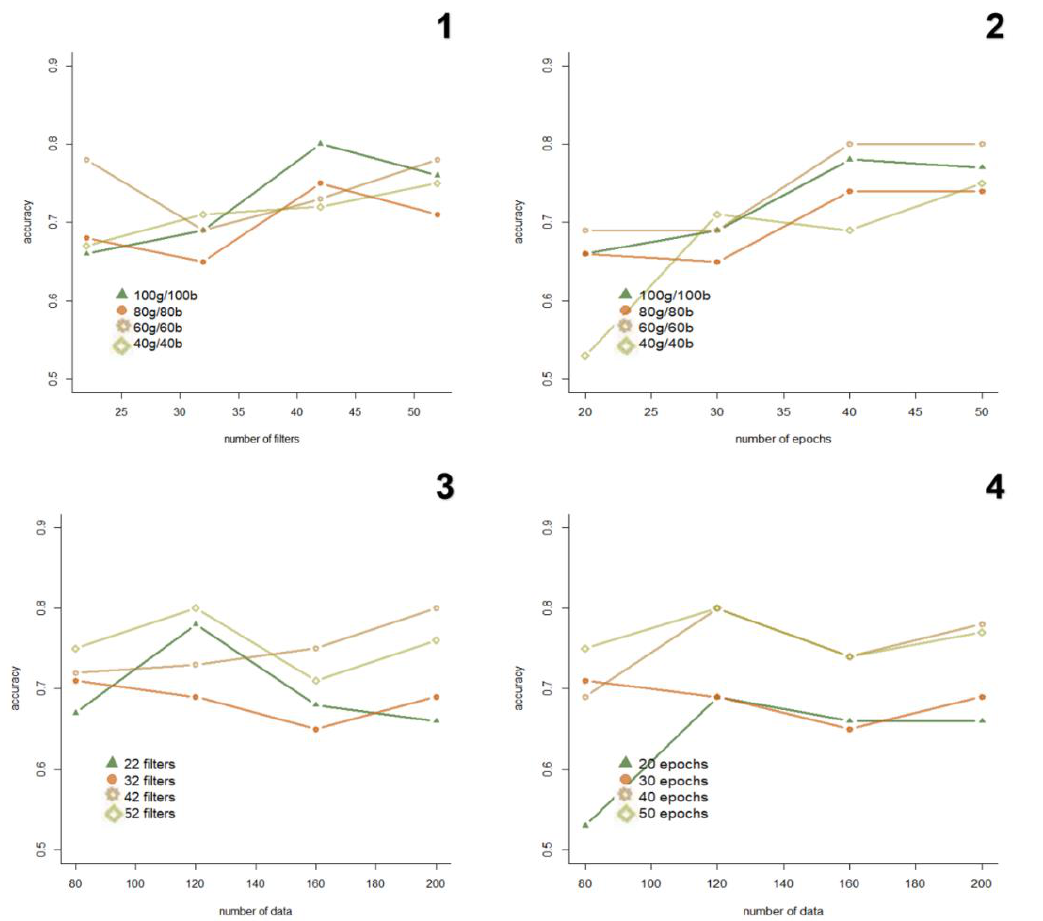
Figure 4. Changes of accuracy based on di ff erent numbers of parameters: Plot 1 , Changes of accuracy based on di ff erent numbers of filters with constant 30 epochs; Plot 2 , Changes of accuracy based on di ff erent numbers of epochs with constant 32 filters; Plot 3 , Changes of accuracy based on di ff erent numbers of data with constant 30 epochs; Plot 4 , Changes of accuracy based on di ff erent numbers of data with constant 32 filters.